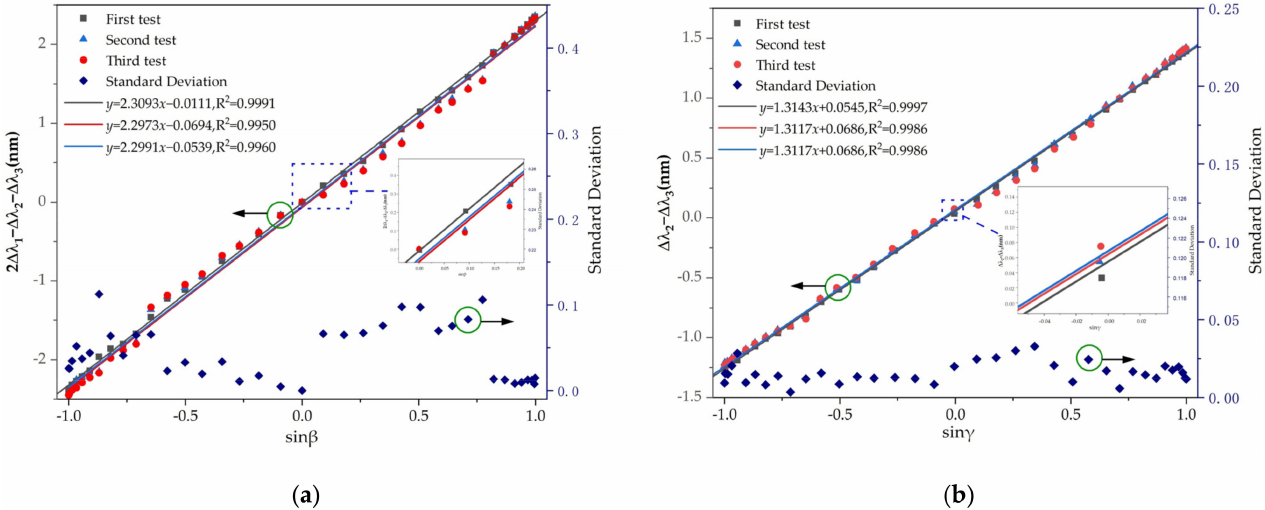
Figure 8. Multiple measured relationship of the central wavelength shift and standard deviation vs. the sine of the attitude angle. ( a ) Central wavelength shift and standard deviation vs. the sine of the pitch angle. ( b ) Central wavelength shift and standard deviation vs. the sine of the roll